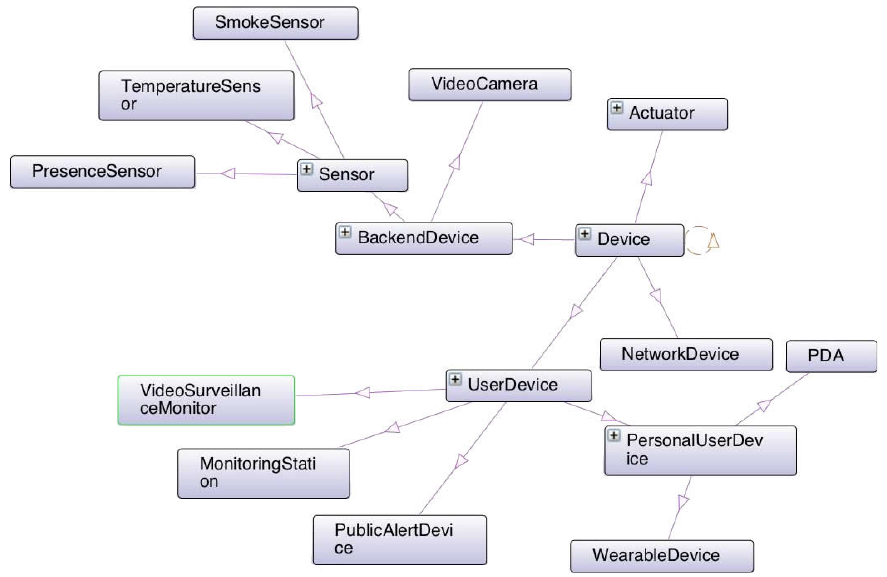
Figure 1. Snippet of the smart city’s